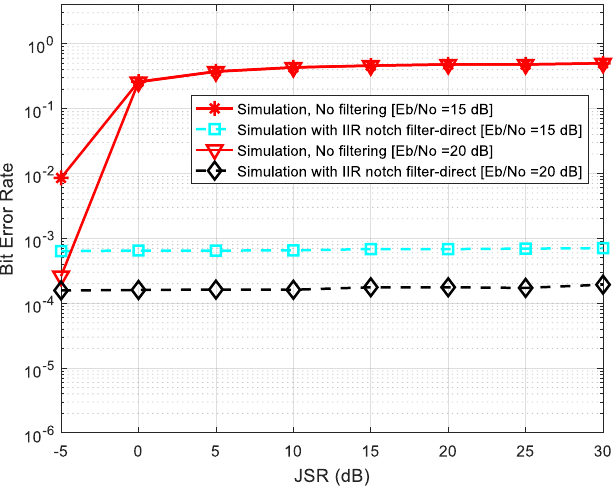
Figure 14. BER vs. JSR, using an S-ANF.